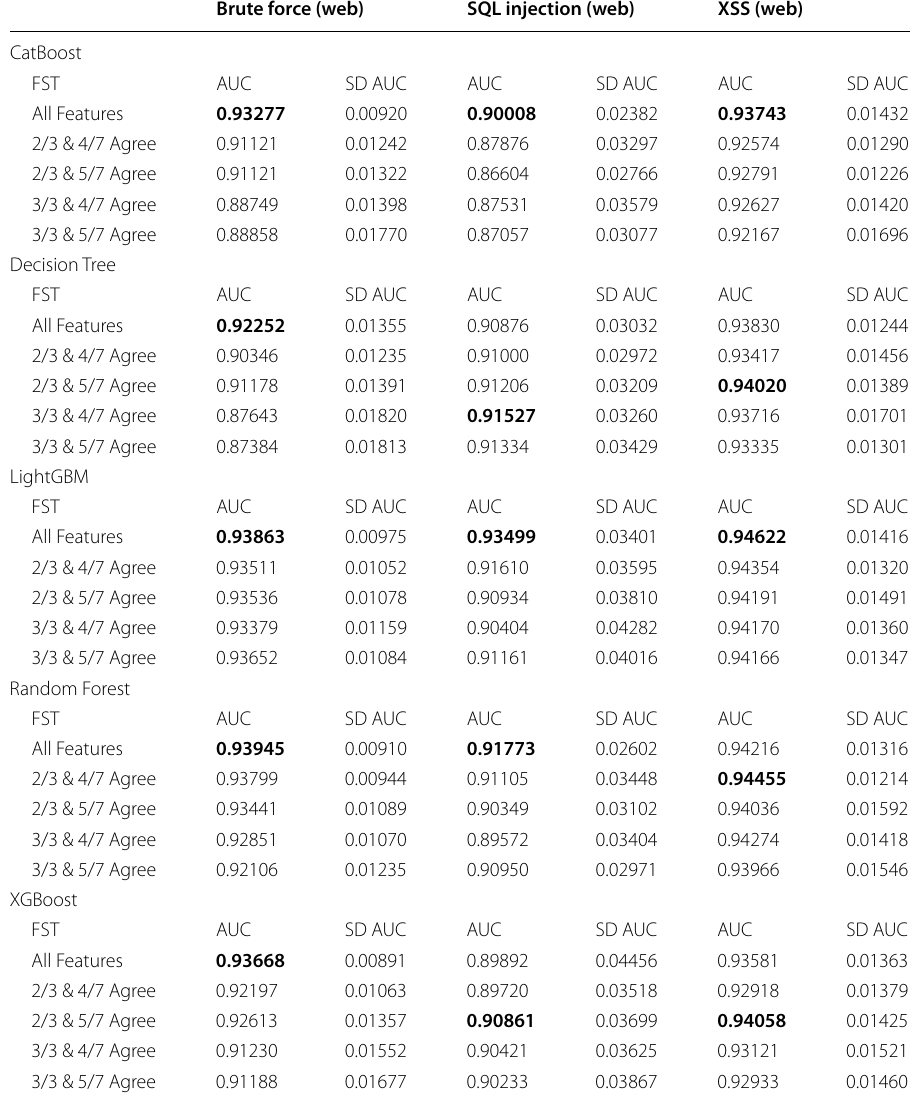
Table 13 Classification performance for 4 feature popularity lists (plus all features), 3 web